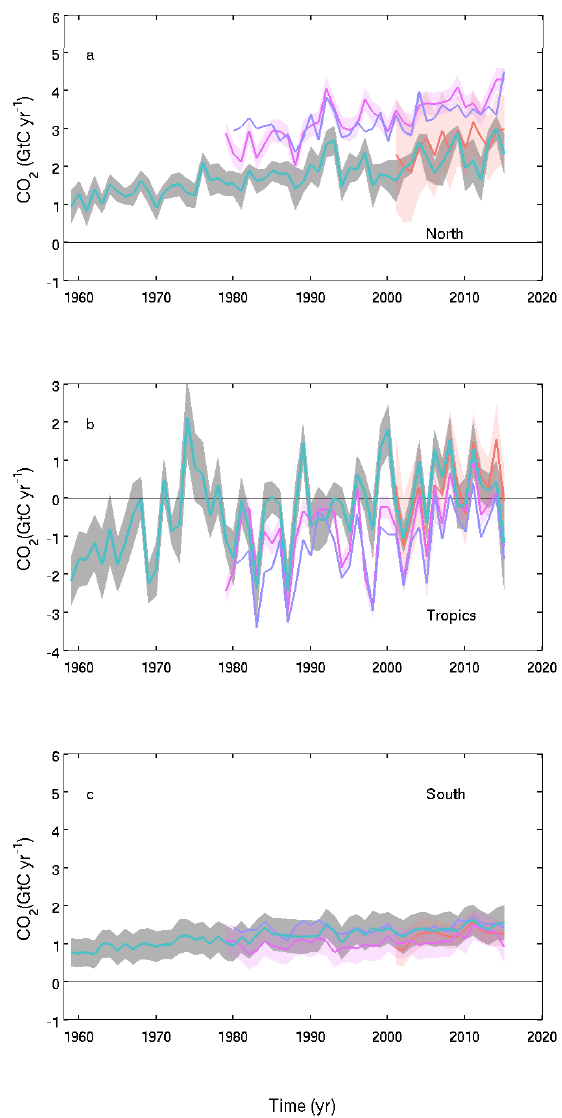
Figure 8. CO 2 fluxes between the atmosphere and the surface ( S OCEAN + S LAND − E LUC ) by latitude bands for the (a) north (north of 30 ◦ N), (b) tropics (30 ◦ S–30 ◦ N), and (c) south (south of 30 ◦ S). Estimates from the combination of the multi-model means for the land and oceans are shown (turquoise) with ± 1 σ of the model ensemble (in grey). Results from the three atmospheric inver- sions are shown from Chevallier et al. (2005; CAMSv15.2) in pur- ple, Rödenbeck et al. (2003; Jena CarboScope, s81_v3.8) in blue, and Peters et al. (2010; CarbonTracker, CTE2016-FT) in salmon; see Table 6. Where available, the uncertainty in the inversions is also